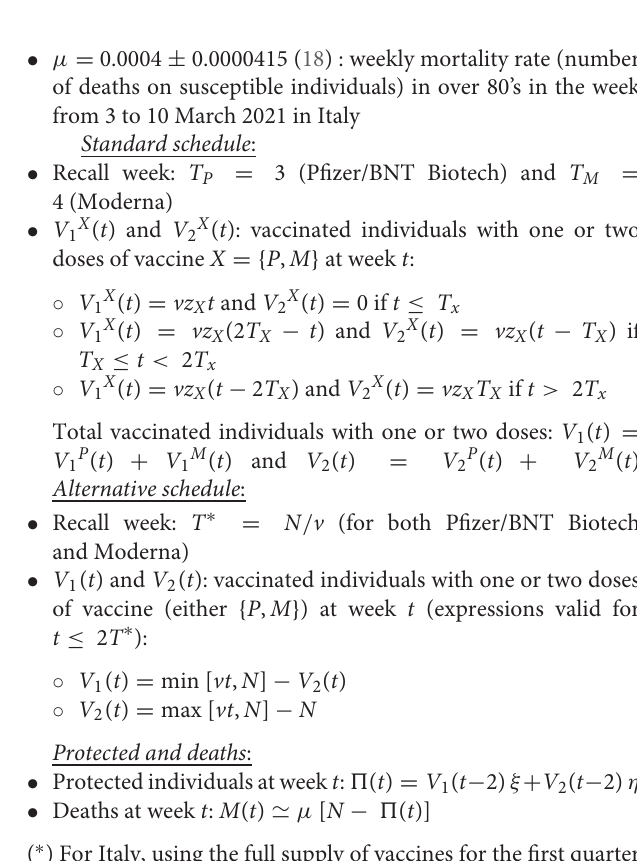
Standard schedule: recall after 3-4